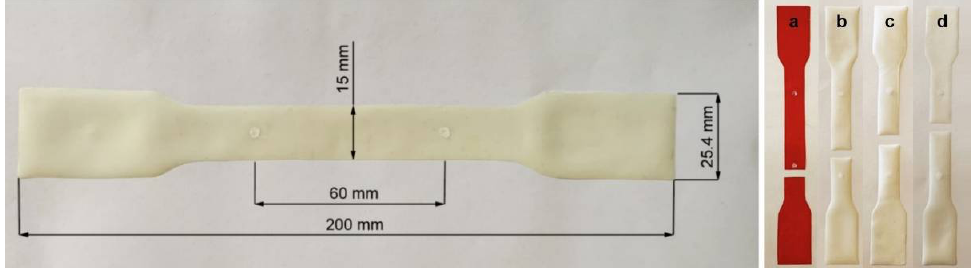
Figure 2. Photograph and dimensions of a tensile test specimen of the PU membrane, and examples of specimens after rupture: PU/CR ( a ), PU ( b ), PU/TRIS ( c ) and PU/MBCD ( d ).